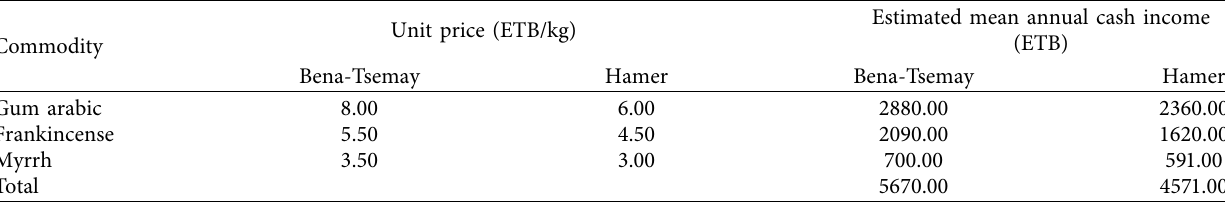
Table 7: Mean annual cash income (in ETB) obtained by household heads from the sale of gum-resin products in South Omo Zone